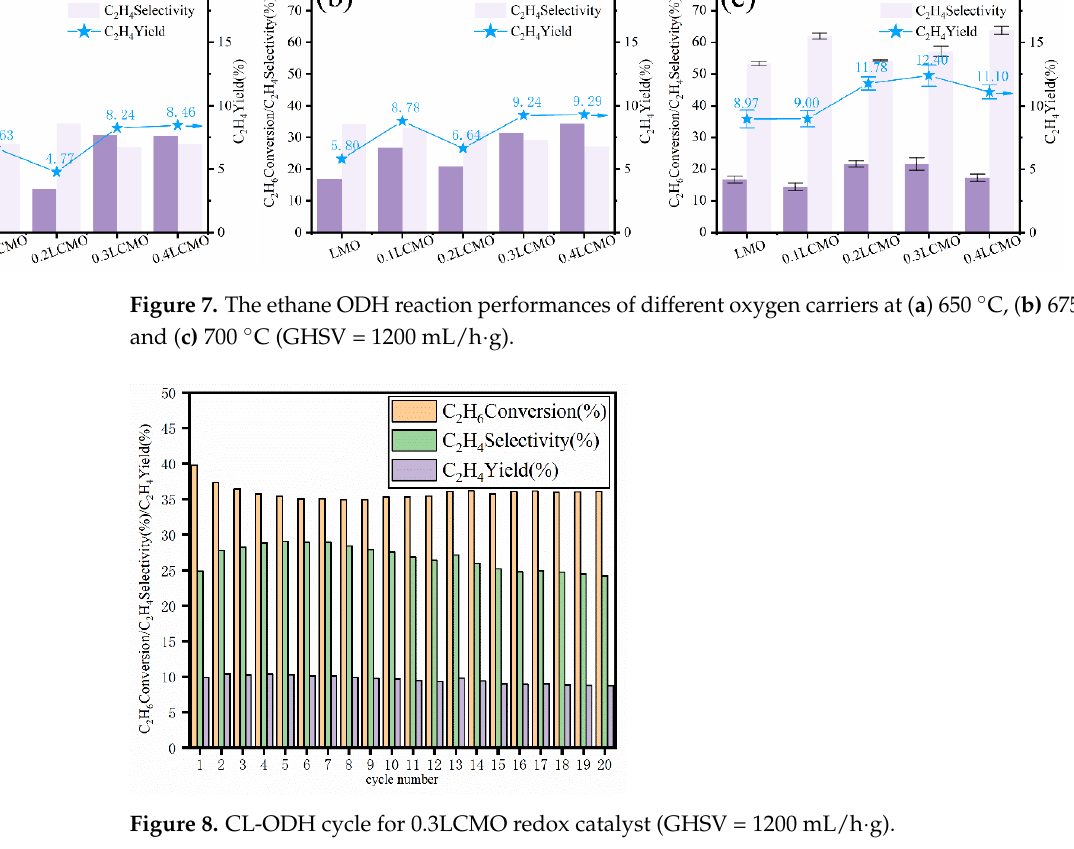
Figure 8. CL-ODH cycle for 0.3LCMO redox catalyst (GHSV = 1200 mL/h · g).